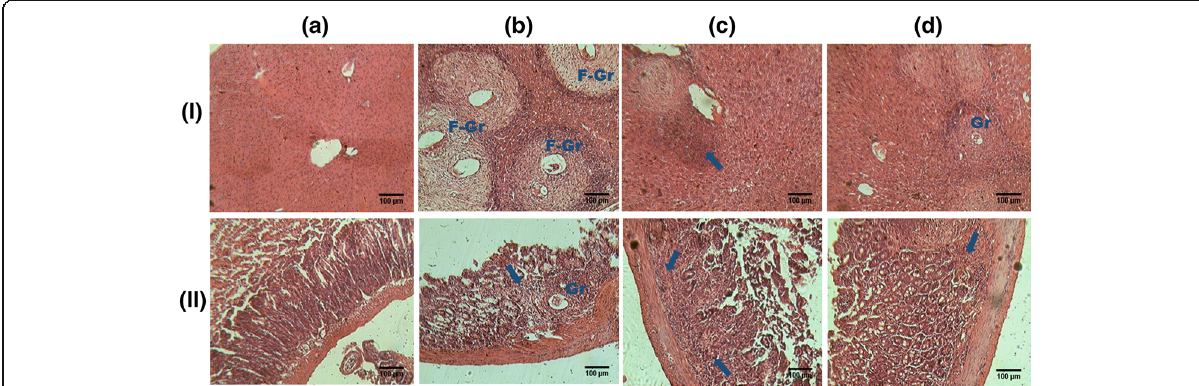
Fig. 1 Effect of oral treatment of Sida pilosa aqueous extract on the liver ( I ) and ileum ( II ) histology of Schistosoma mansoni -infected mice. Arrows: indicate inflammatory cells infiltration; F-Gr: fibrotic granuloma; Gr: granuloma. In uninfected-untreated mice, liver ( I - a ) and ileum sections ( II - a ) showed normal structure. Multiple and voluminous granulomas surrounded with fibrous tissue were present in the liver sections of infected-untreated mice ( I - b ). The mucosa of their ileum contains nonfibrotic granulomas and the muscular layer was thickened ( II - b ). In the liver ( I - c ) and ileum sections ( II - c ) of SpAE- treated mice, scare and small granulomas were detected; while in PZQ-treated mice, liver ( I - d ) and ileum sections ( II - d ) were nearly free of granulomas regressed to 7.64 ± 0.37 after SpAE treatment or to 5.26 ± 0.91 after PZQ treatment, corresponding to a reduction of 48.76% and 64.72% respectively. No statistical difference was found between SpAE and PZQ groups (Fig. 2I-b).